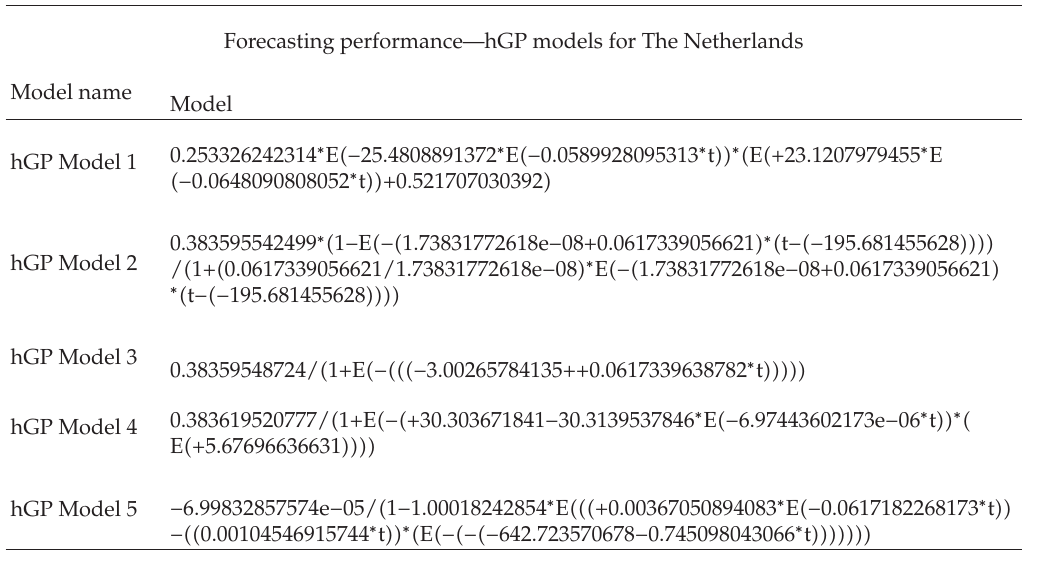
Table 33: Representation of the first five produced hGP models in forecasting (cid:2) The Netherlands (cid:3) . Forecasting performance—hGP models for The Netherlands